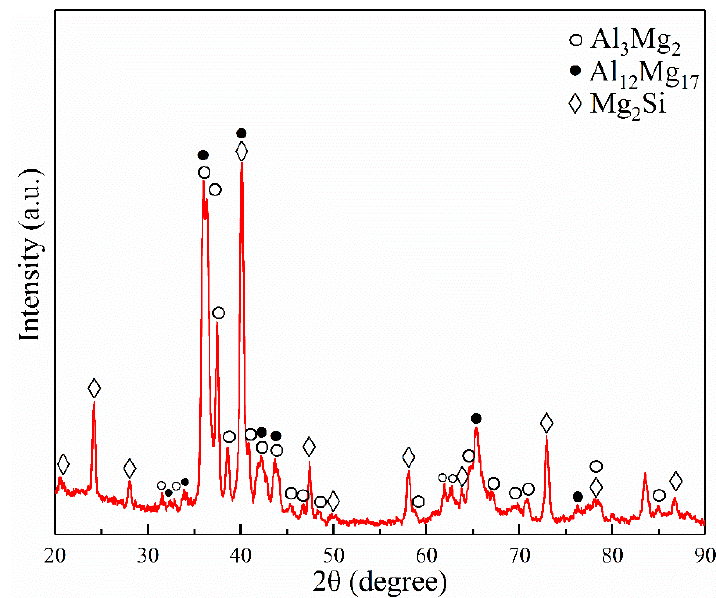
Figure 11. XRD diagram of the IMCs layer of the Mg–Al interface.